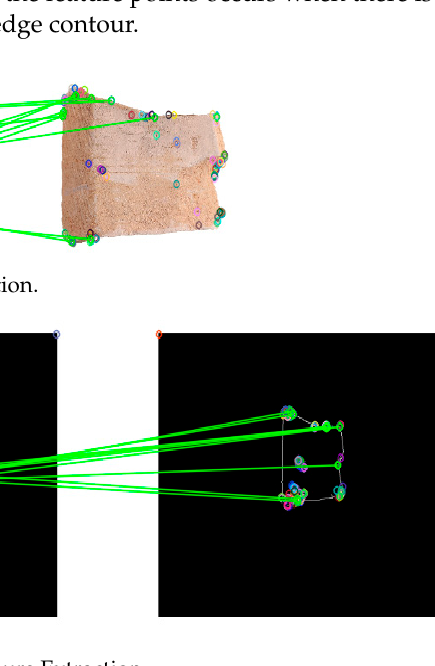
Figure 5. Binarized ORB Feature Extraction.